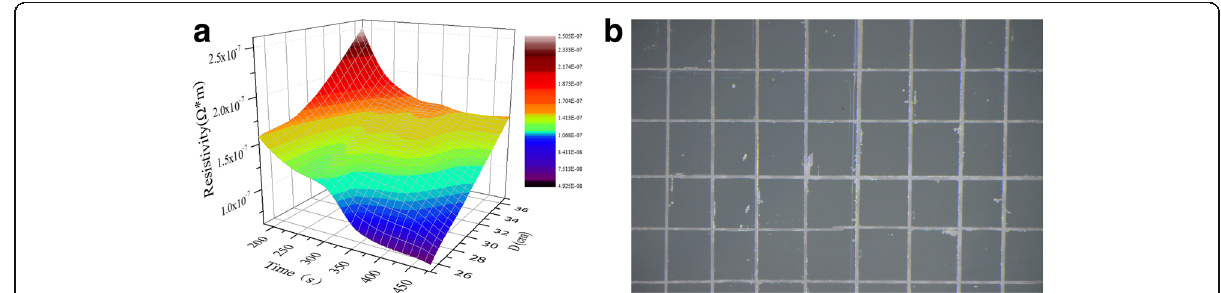
Fig. 6 a 3D image for the electrical resistivity of the silver fims cured at different UV curing conditions. b Photo of UV-cured silver films on glass after tape